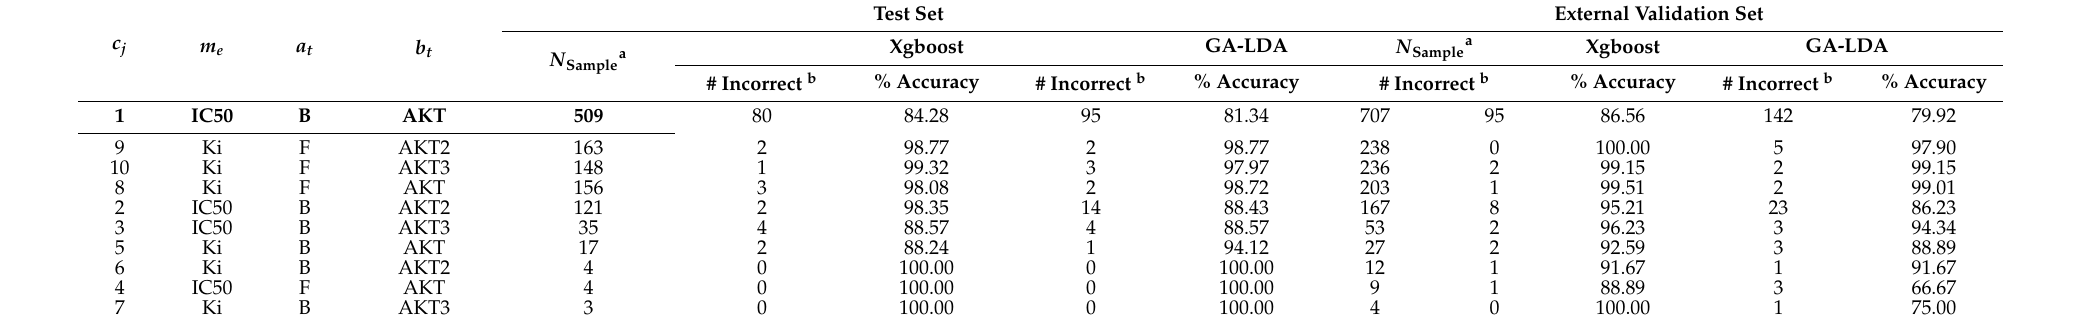
Table 7. The predictive accuracies of GA-LDA and Xgboost models with respect to the different experimental elements c j